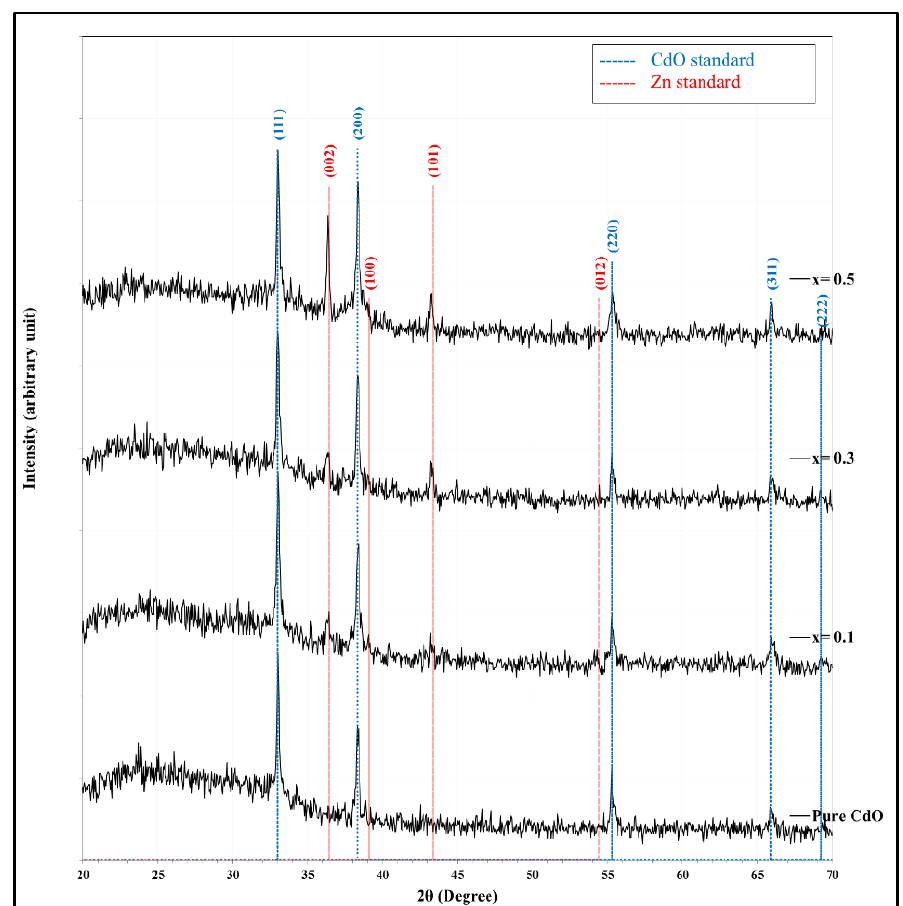
Figure 1: X-ray diffraction patterns of pure and Zn-doped CdO thin films at different ratios prepared by 400 mJ pulsed